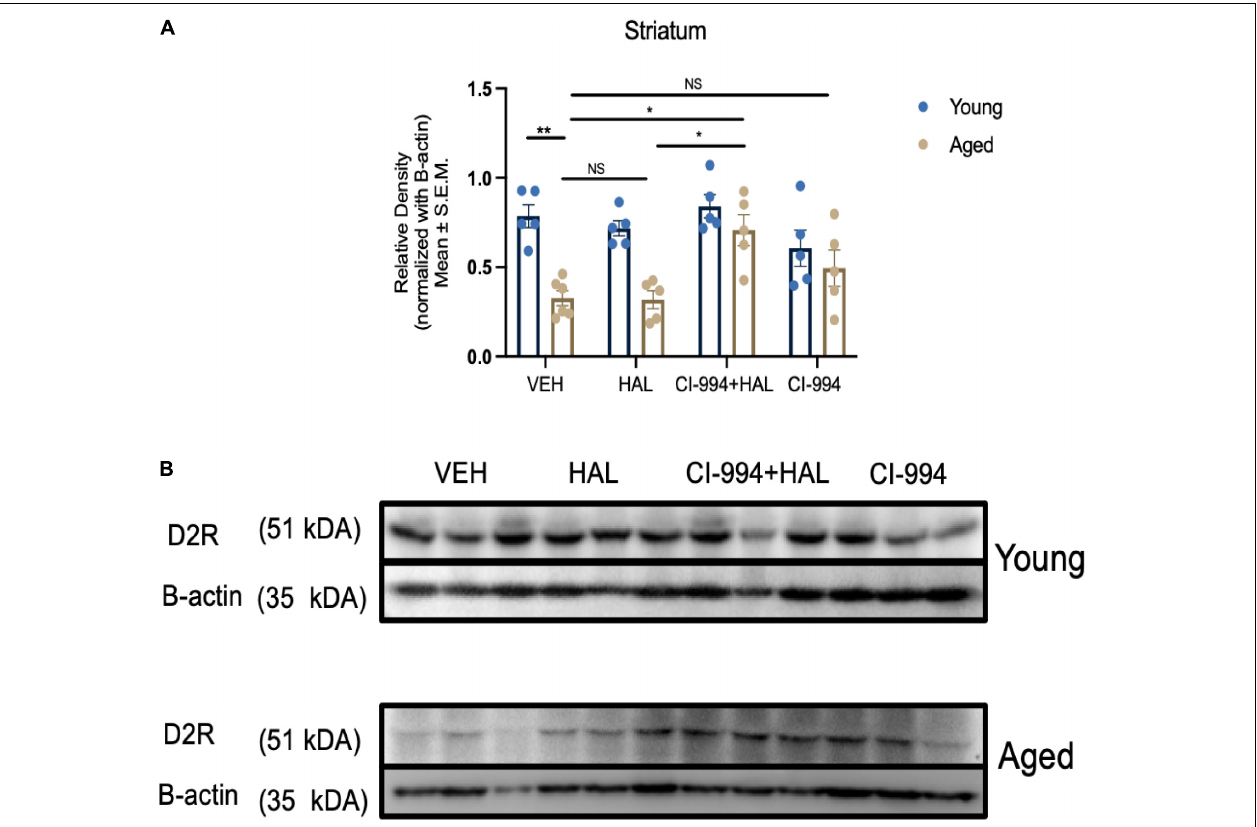
FIGURE 4 | CI-994 restores D2R protein expression in the striatum of aged mice. (A) Quantitative analysis of D2R protein expression levels in the young and aged striatum through immunoblotting. Aged mice showed a significant decrease in D2R expression (aged VEH vs. young VEH, p = 0.0011), however, HAL treatment during aging did not impact D2R expression (aged VEH vs. aged HAL, p > 0.9999). CI-994 + HAL 20 mg/kg treatment significantly increased D2R expression (aged VEH vs. aged CI-994 + HAL 20 mg/kg, p = 0.0102; aged HAL vs. aged CI-994 + HAL 20 mg/kg, p = 0.0130). However, CI-994 20 mg/kg treatment did not have an effect on D2R expression (aged CI-994 20 mg/kg vs. aged VEH, p = 0.6779). (B) Western blot images from panel (A) . Each band represents a different biological sample in each treatment group. Data represent mean ± SEM ( n = 5–6/per group). * p < 0.05, ** p < 0.01, NS, not